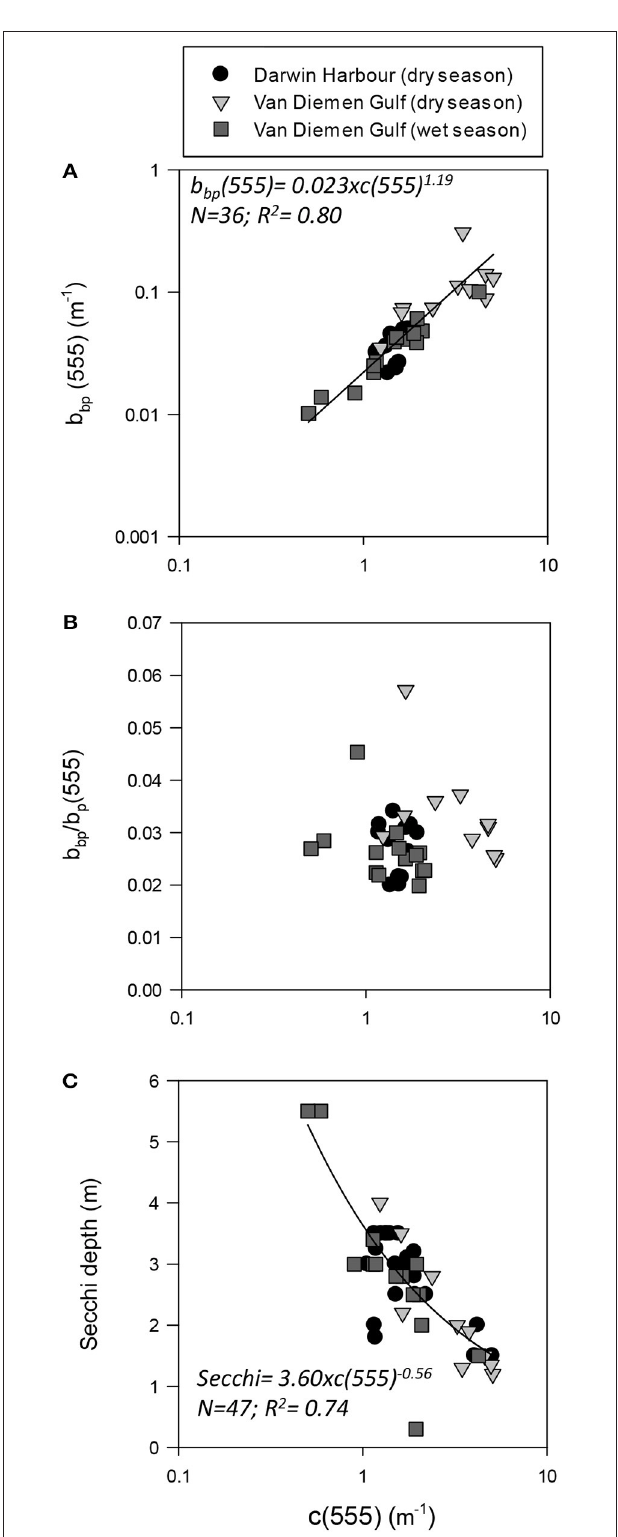
FIGURE 6 | Beam attenuation coefficient (c 555 ) as a function of (A) backscattering (b bp555 ); (B) the backscattering-to-scattering ratio (b b555 ); and (C) Secchi